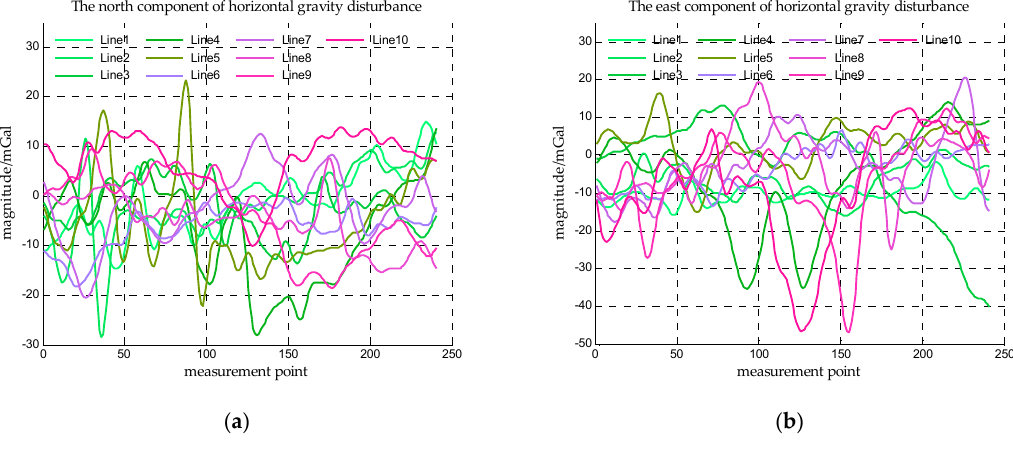
Figure 8. The horizontal gravity disturbance on the survey lines. ( a ) is the north component of horizontal gravity disturbance on survey lines and ( b ) is the east component of horizontal gravity disturbance on survey lines. Table 1. The coordinate range of the survey lines.